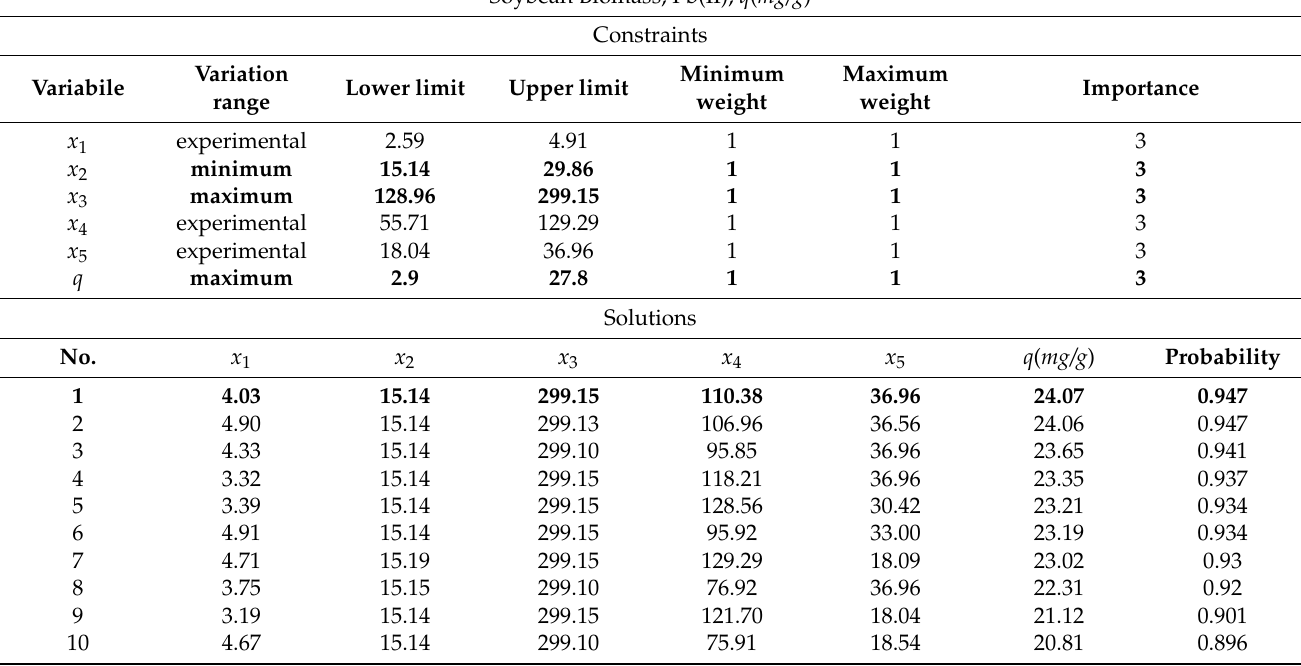
Table 13. Solutions for the operation in favorable conditions for reaching the maximum value of the biosorption capacity ( q , mg/g ) of soybean biomass and soybean waste biomass considering a series of constraints (minimum dose of sorbent and maximum concentration of the metal ions in